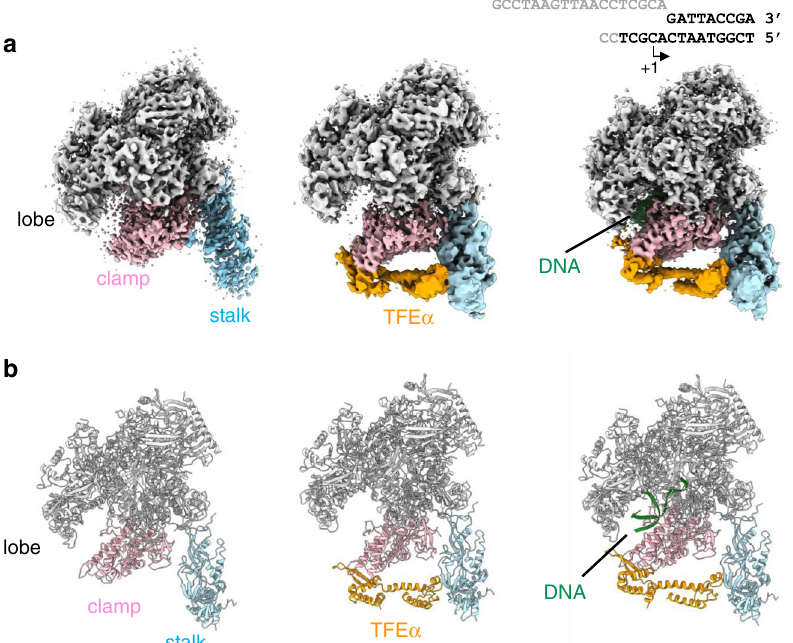
Fig. 2 Cryo-EM structures of three different forms of the Tko RNAP. a Cryo-EM density maps of the apo-form (left), RNAP – TFE α binary complex (center), and RNAP – TFE α – DNA ternary complex (right). Domains of RNAP and DNA are indicated and variably colored. The DNA used for preparing the ternary complex is shown (right). DNA bases shown in gray are disordered in the structure. Note that the cryo-EM maps of RNAP – TFE α binary complex and RNAP – TFE α – DNA ternary complex are the composite maps produced from globally re fi ned maps and focused re fi nements on the region containing TFE α , stalk and cleft domains. b Ribbon models of the apo-form (left), binary complex (center) and ternary complex (right) in the same color and orientation as in ( a